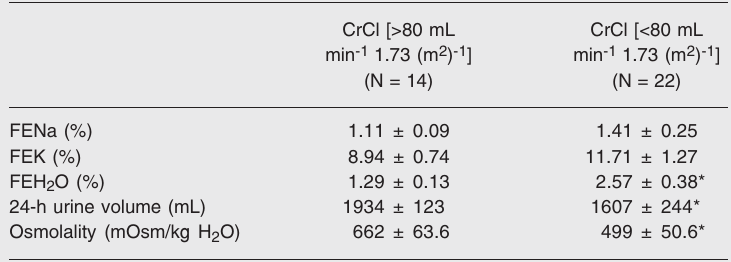
Table 2. Renal function of the 36 indinavir-treated patients according to creatinine